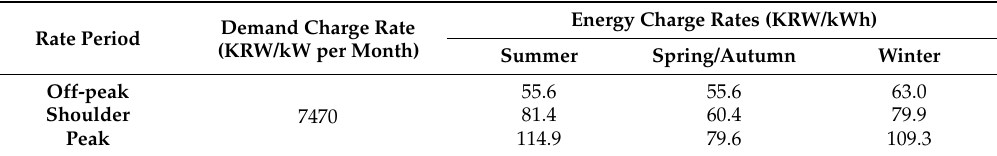
Table 1. An example of the industrial electricity TOU tariff in